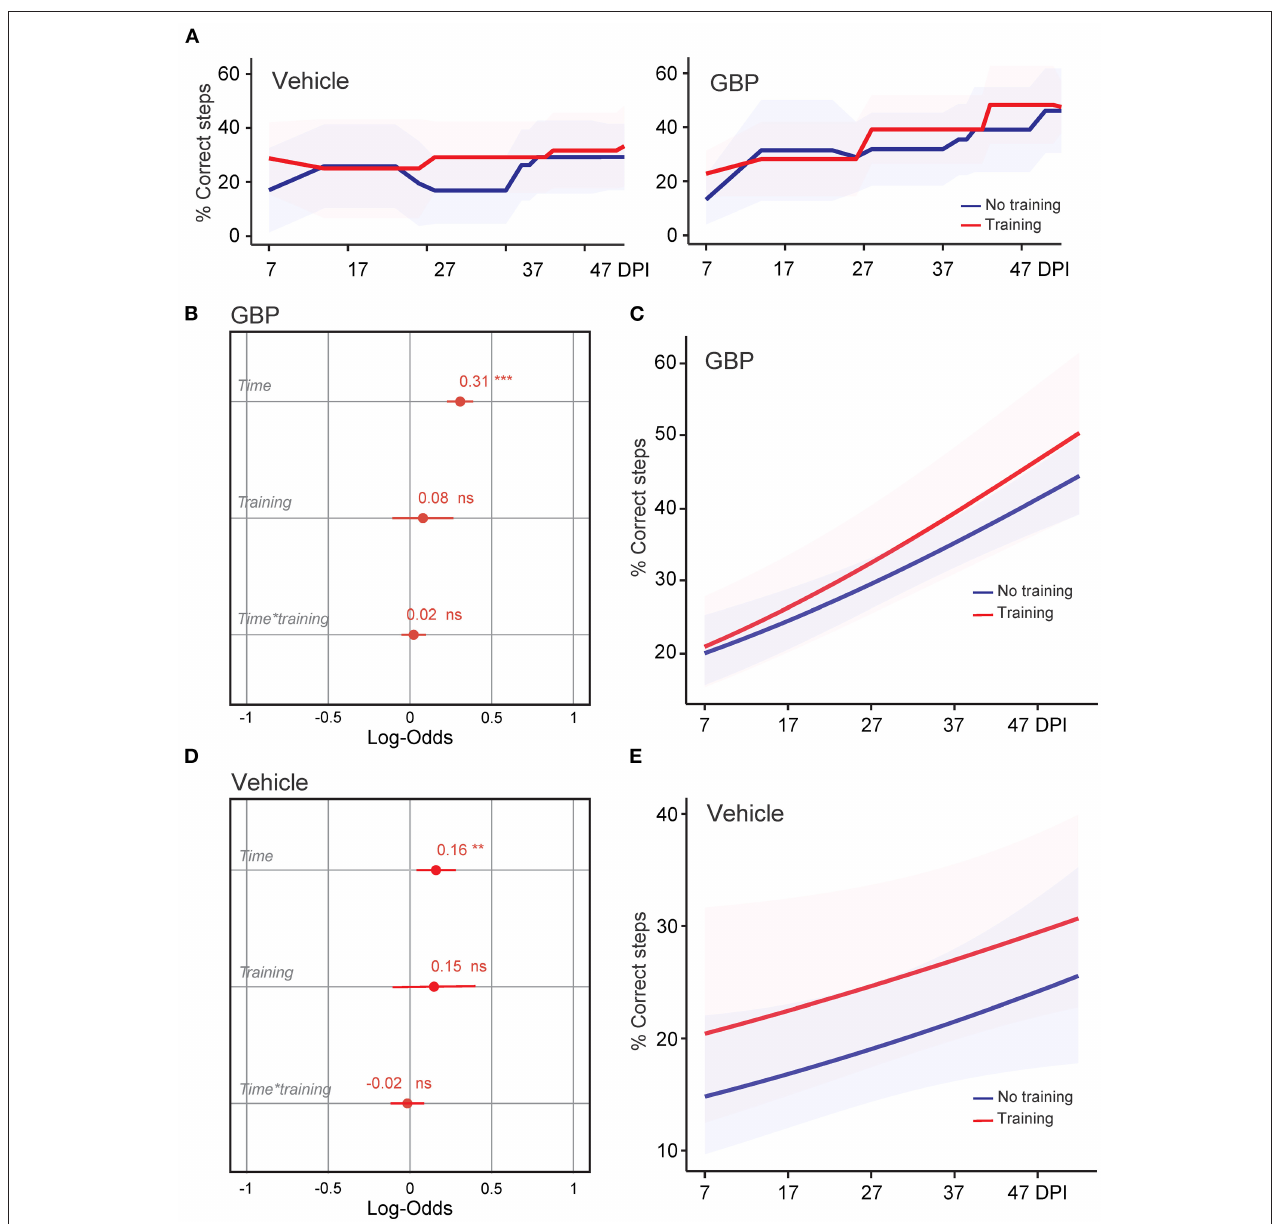
FIGURE 2 | Treadmill training in combination with GBP administration does not improve skilled walking. (A) Recovery of forelimb skilled locomotor function was measured using the horizontal ladder rung-walking test. Mean and standard deviation (vehicle without treadmill training n = 25, vehicle with treadmill training n = 13, GBP without treadmill training n = 25, GBP with treadmill training n = 14). Of note, SCI mice (vehicle and GBP) without treadmill training originated from our previous study (Sun et al., 2020). (B) Analysis of (A) . Variable effects on forelimb skilled locomotor function in mice administered GBP are displayed as coefficients with confidence intervals (Generalized linear mixed effect model for repeated measures *** p < 0.001, ns not significant, GBP without treadmill training n = 25 and GBP with treadmill training n = 14 mice). Of note, SCI mice administered GBP without treadmill training originated from our previous study (Sun et al., 2020). (C) Predicted changes in forelimb skilled locomotor function in mice administered GBP. Shaded error bands indicate confidence intervals. (D) Analysis of (A) . Variable effects on forelimb skilled locomotor function in mice administered vehicle are displayed as coefficients with confidence intervals (Generalized linear mixed effect model for repeated measures ** p < 0.01, ns not significant, vehicle without treadmill training n = 25 and vehicle with treadmill training n = 13 mice). Of note, SCI mice administered vehicle without treadmill training originated from our previous study ( Sun et al., 2020). (E) Predicted changes in forelimb skilled locomotor function in mice administered vehicle. Shaded error bands indicate confidence